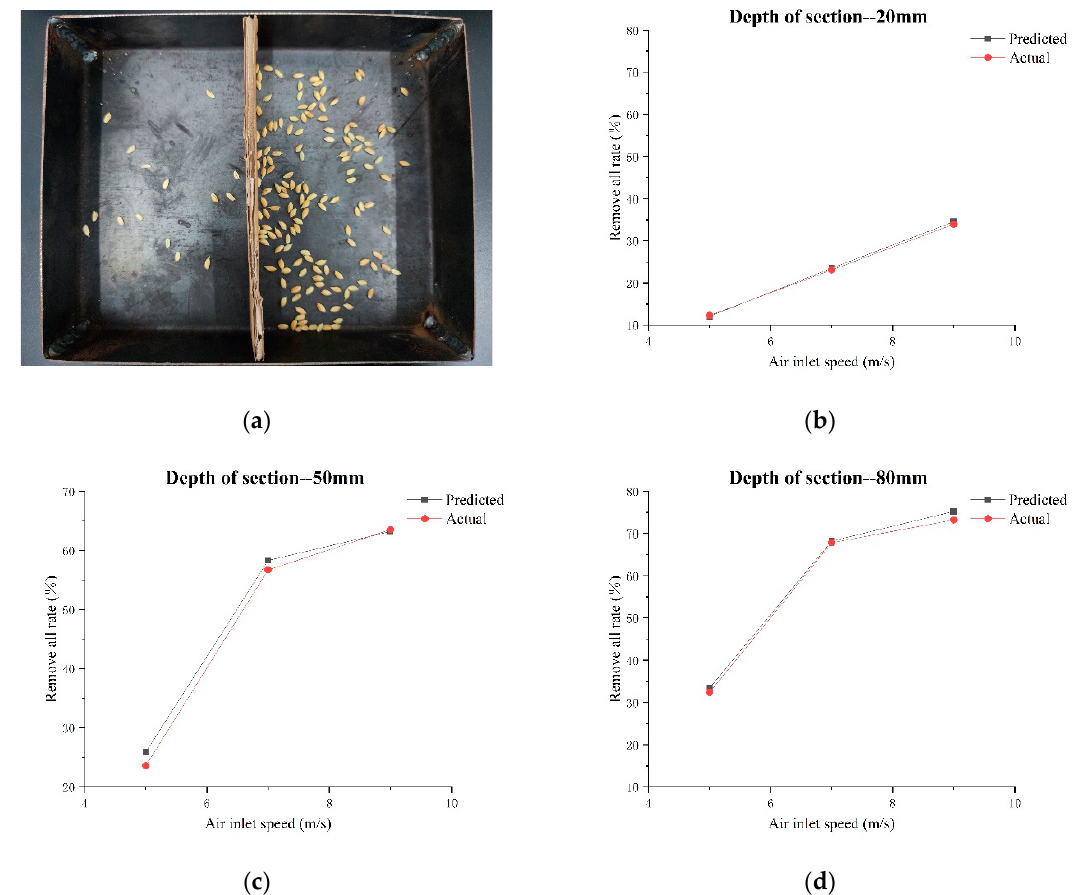
Figure 9. Verification diagram of solid and unfilled grain test after screening: ( a ) the distribution of solid and unfilled grains after screening; ( b ) x 1 , x 3 , and x 4 were 20 mm, 200 mm, and 60 mm, respectively, the relationship between the removal rate of predicted and actual; ( c ) x 1 , x 3 , and x 4 were 50 mm, 200 mm, and 60 mm, respectively, the relationship between the removal rate of predicted and actual; ( d ) x 1 , x 3 , and x 4 were 80 mm, 200 mm, and 60 mm, respectively, the relationship between the remove all rate of predicted and